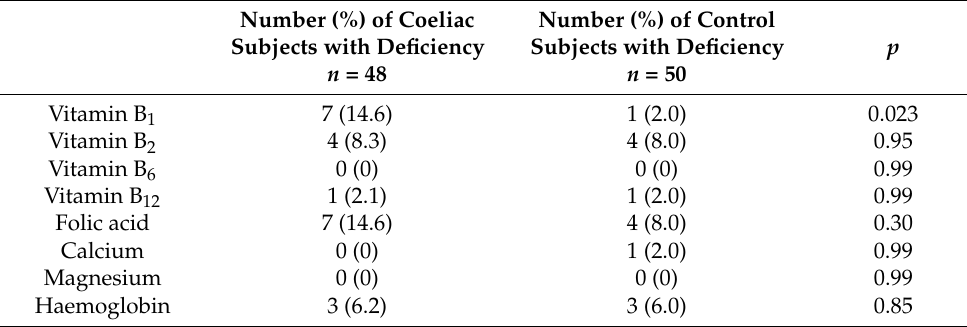
Table 4. Number of CD and control subjects with micronutrient deficiencies.